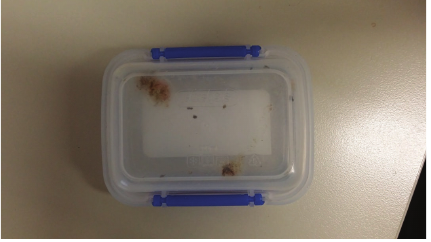
Figure 1: Specimen containing “proof” of the patient’s